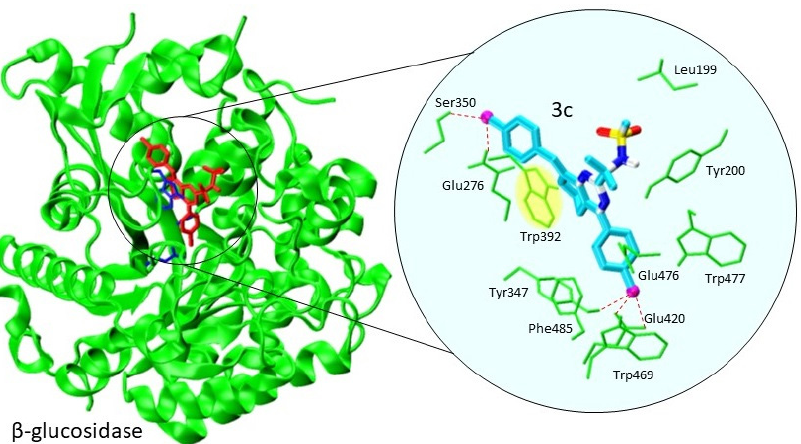
Figure 4. The best docking pose of 3c at Raucaffricine β -glucosidase (PDB code 4A3Y). The enzyme is shown as a ribbon model in green and 3c is represented as a licorice model in red. The active site residues Glu186, Trp392, and Glu420 of β -glucosidase are shown as blue sticks. An insert outlines protein–ligand interactions of 3c with neighboring enzyme residues (a key Trp392 is highlighted in yellow).